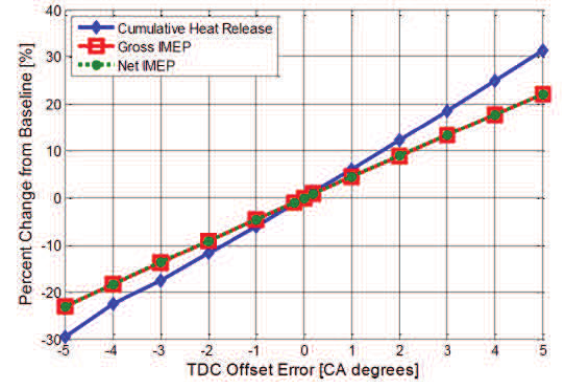
Fig. 10. Effect of TDC offset on cumulative heat release and IMEP [13]